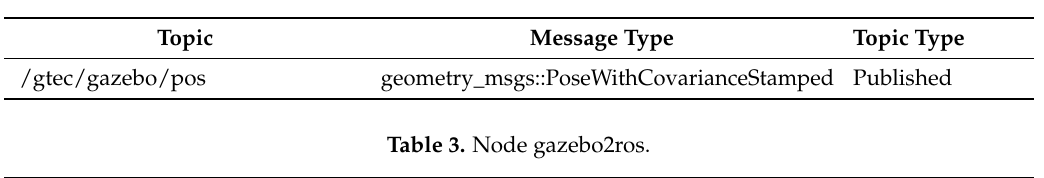
Table 2. Plug-in gtec_tag_pos_publisher.